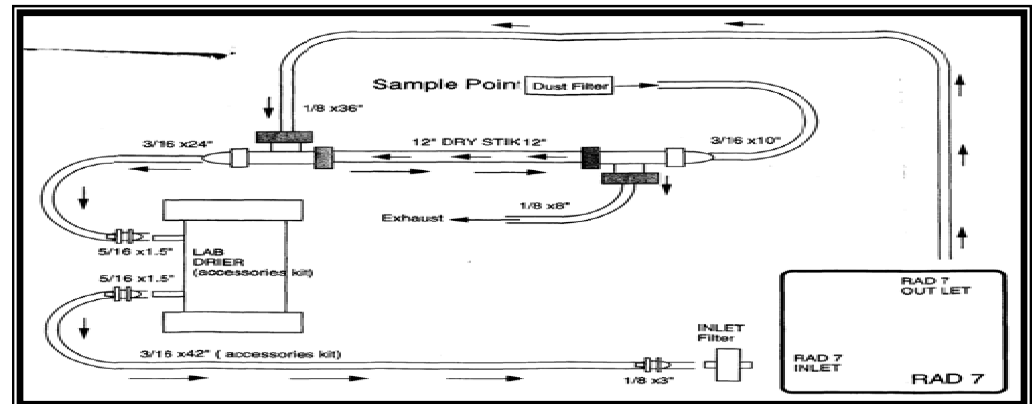
Fig.2: Schematic diagram for the Radon measurement in indoor air